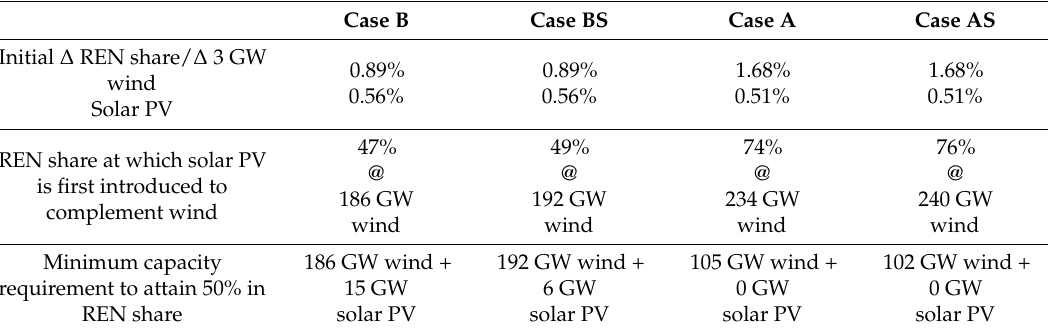
Table 2. Overview of selected results from the calculated